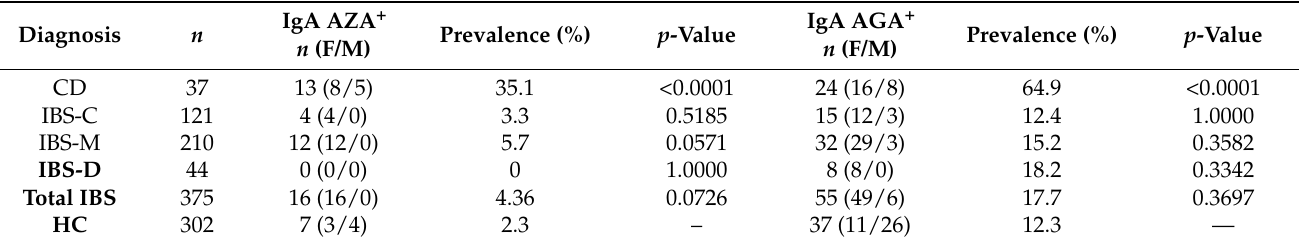
Table 2. Prevalence of anti-zein IgA and anti-gliadin IgA antibodies in celiac disease, irritable bowel syndrome, and healthy controls.